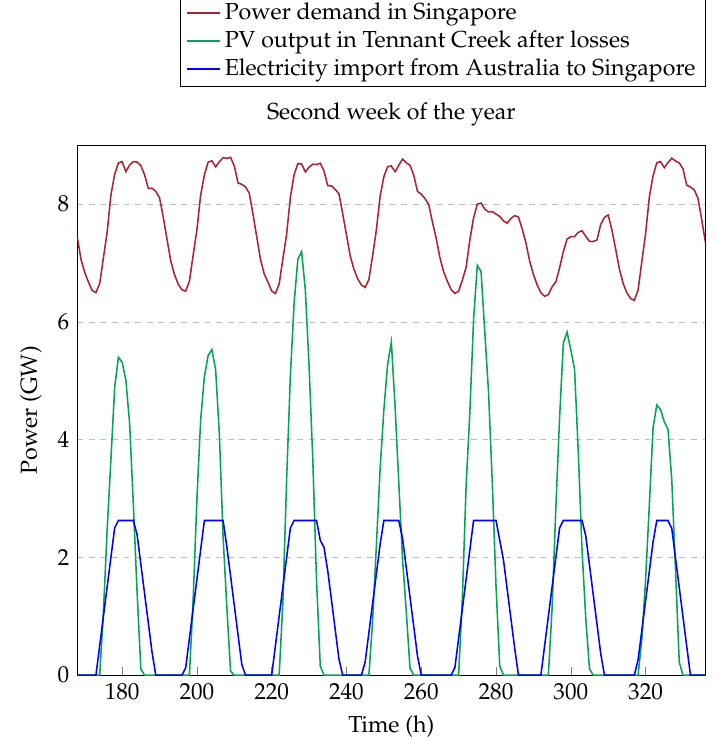
Figure A2. Hourly power demand in Singapore (maroon), PV system output in Tennant Creek (green), and import through the HVDC cable (blue) for a week in January. The difference between the green and blue curve is due to losses in transmission and storage. The use of a large battery system leads to peak shaving and shifting of the power supply to later hours.